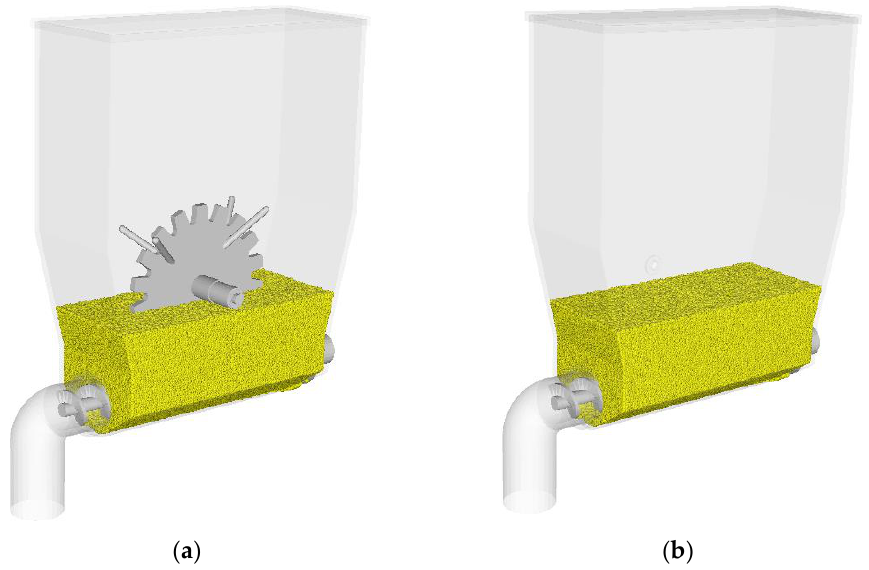
Figure 6. Discrete element model of screw conveyor: ( a ) conveyor model with a seed stirring mech- anism, and ( b ) conveyor model without a seed stirring mechanism.